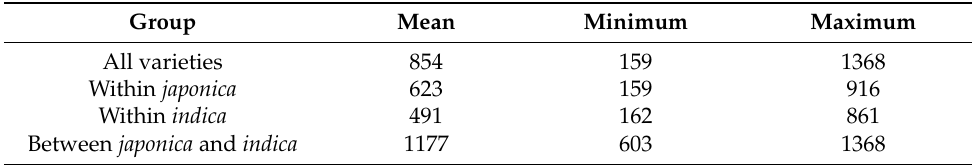
Table 1. Number of polymorphic markers for different variety pairs.